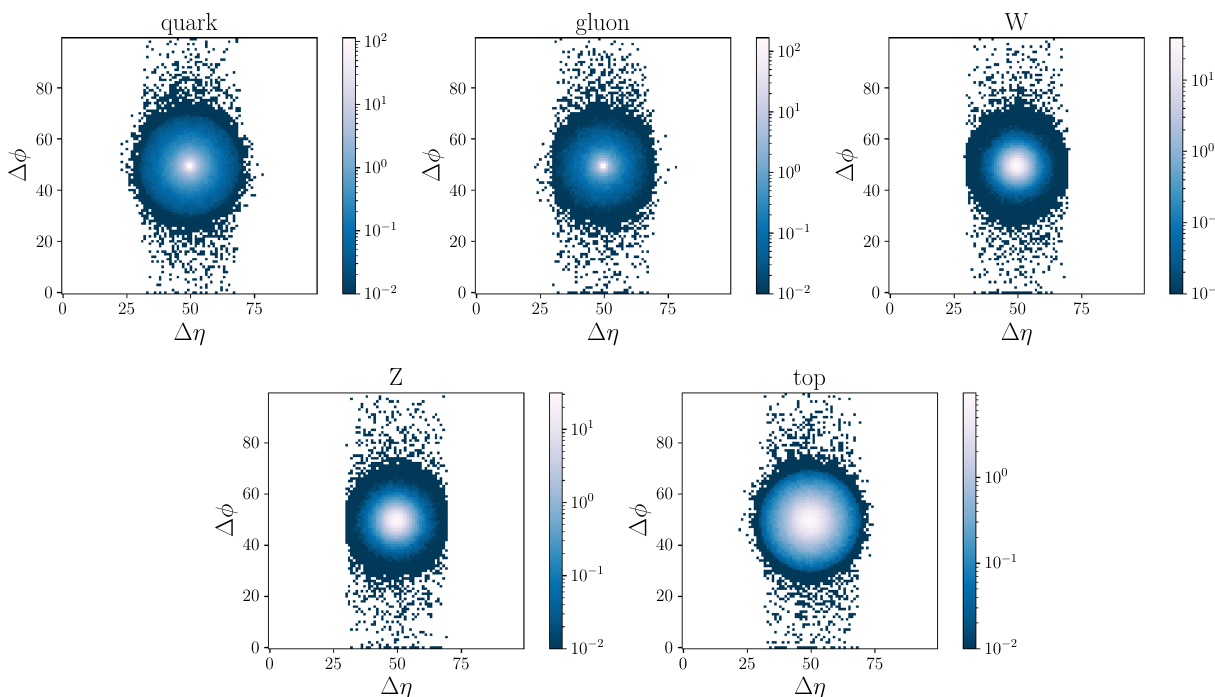
p T collected in each cell of the image, measured in GeV and computed from the scalar sum of the p T of the particles pointing to each